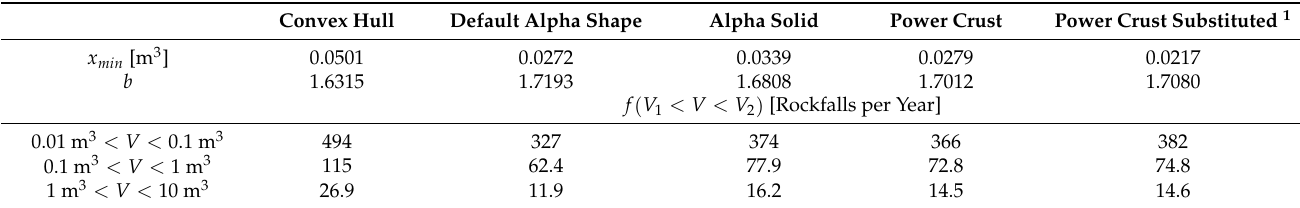
Table 2. Upper : power-law PDF fits for each of the datasets utilizing the Kolmogorov–Smirnov statistic for estimating x min and the MLE of the scaling parameter; Lower : annual rockfall frequency calculations.